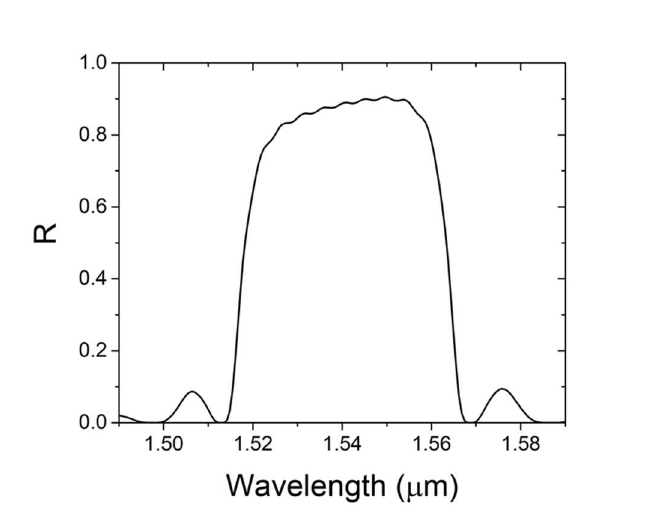
Fig. 6. Spectral response of the waveguide Bragg mirror with 35 periods, a periodicity of 344 nm, and an etching depth of 70 nm.